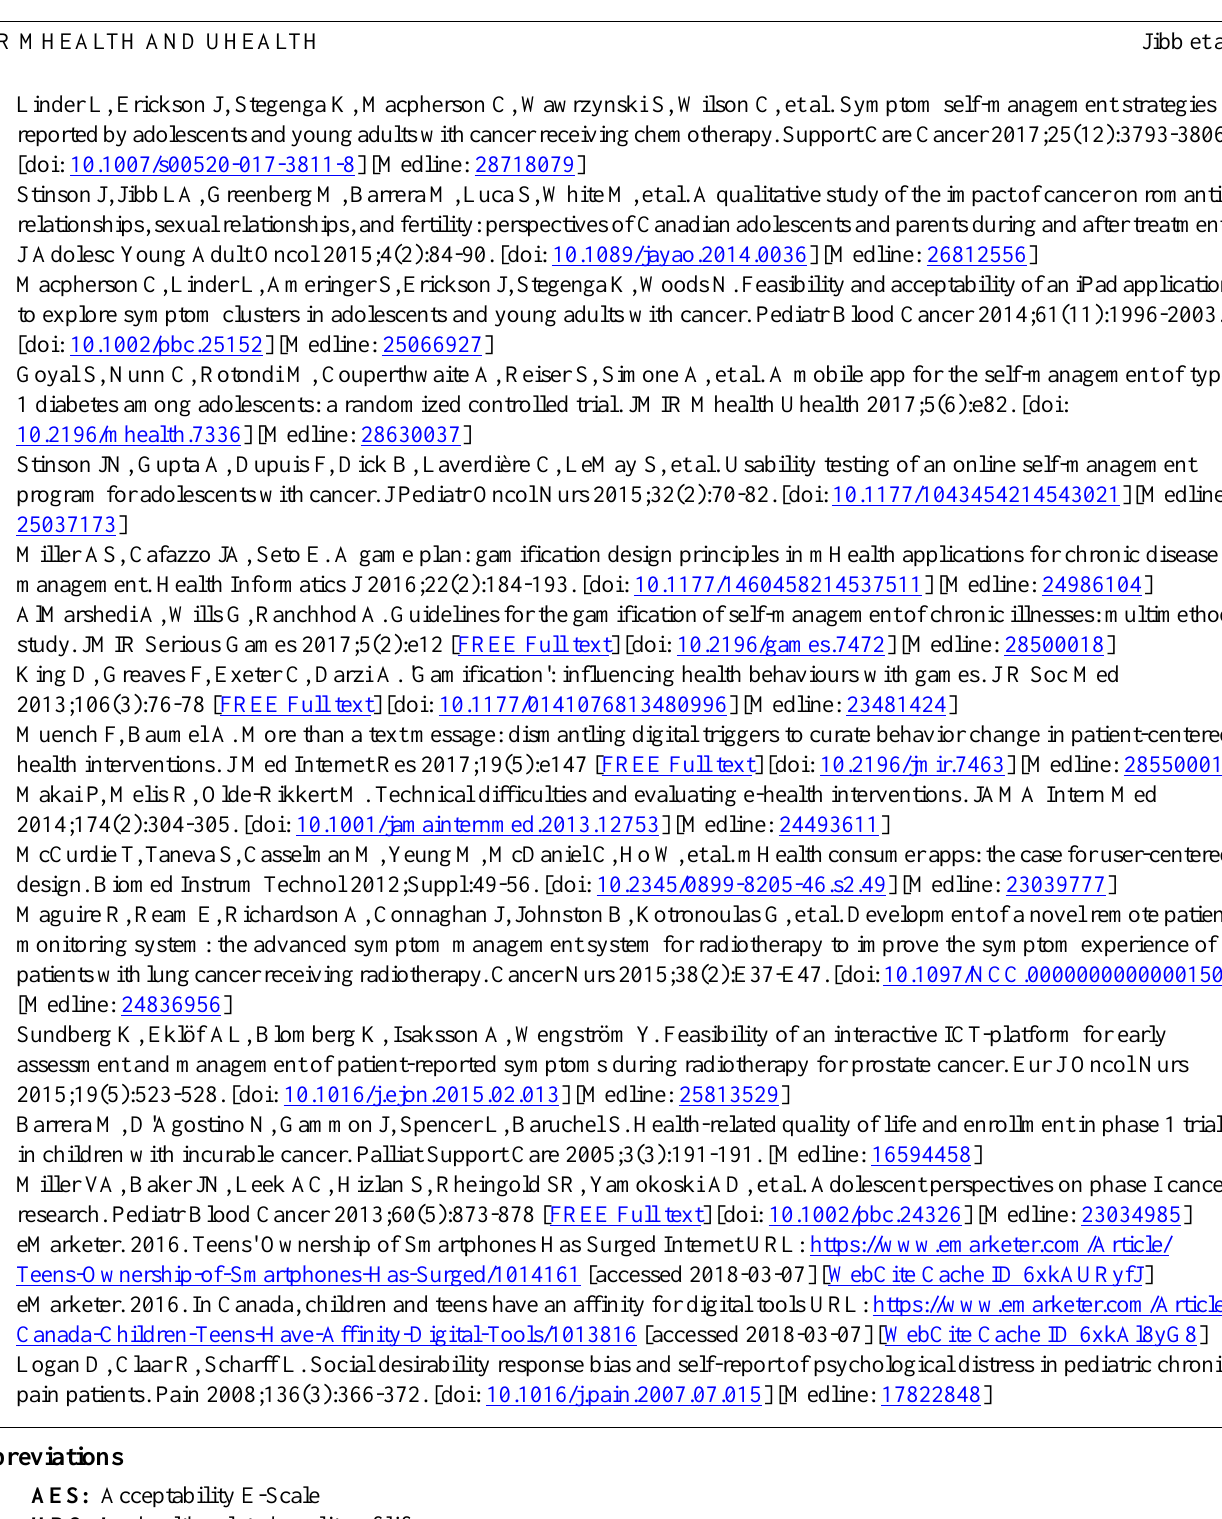
Abbreviations AES: Acceptability E-Scale HRQoL: health-related quality of life RCT: randomized controlled